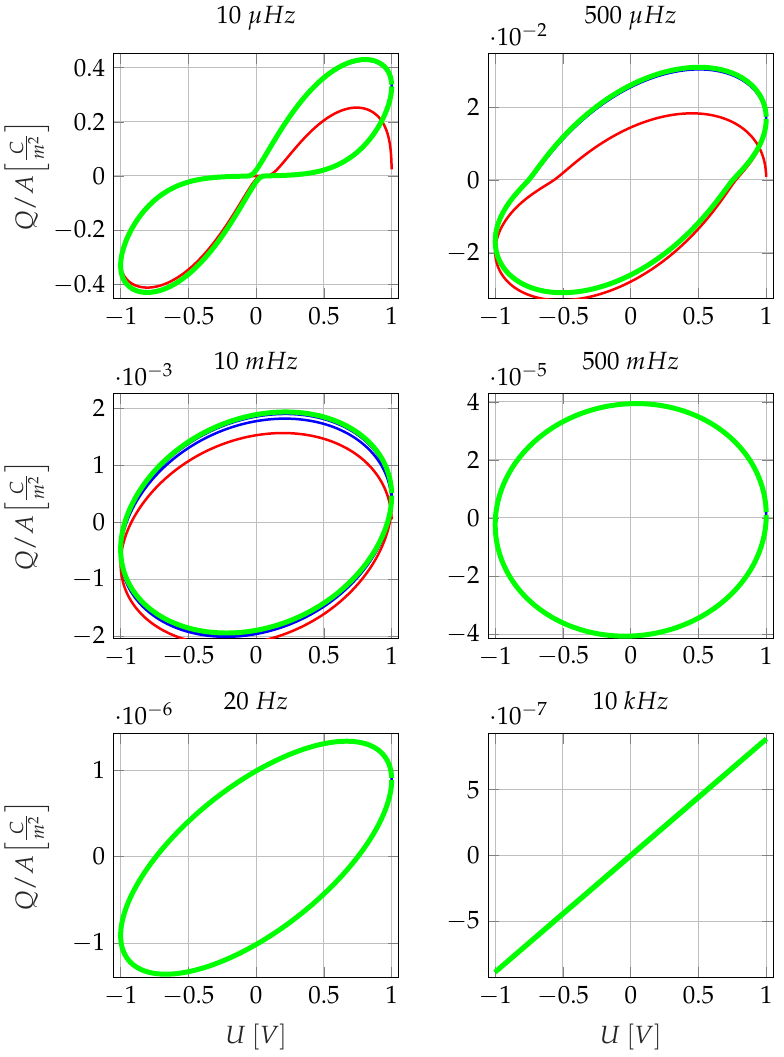
( t ) over cyclic excitation voltage U ( t ) . The pa- Figure 2. Cyclic charge displacement per unit area Q A rameters for the simulation are as following: excitation voltage U = 1V, electrode spacing L = 100µm, diffusion constant D = 10 − 14 m 2 s − 1 , average ion concentration ρ ± ,0 = 10 23 Ionsm − 3 . The red lines indicate the initial cycle, the blue lines (where visible) indicate intermediate cycles, and the green lines indicate the fifth cycle, which is identical to the limit